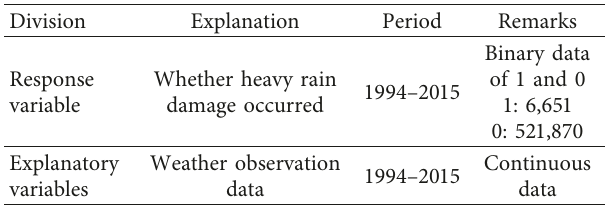
Figure 9: Administrative boundary and ASOS location. Table 3: Types of data for analysis.